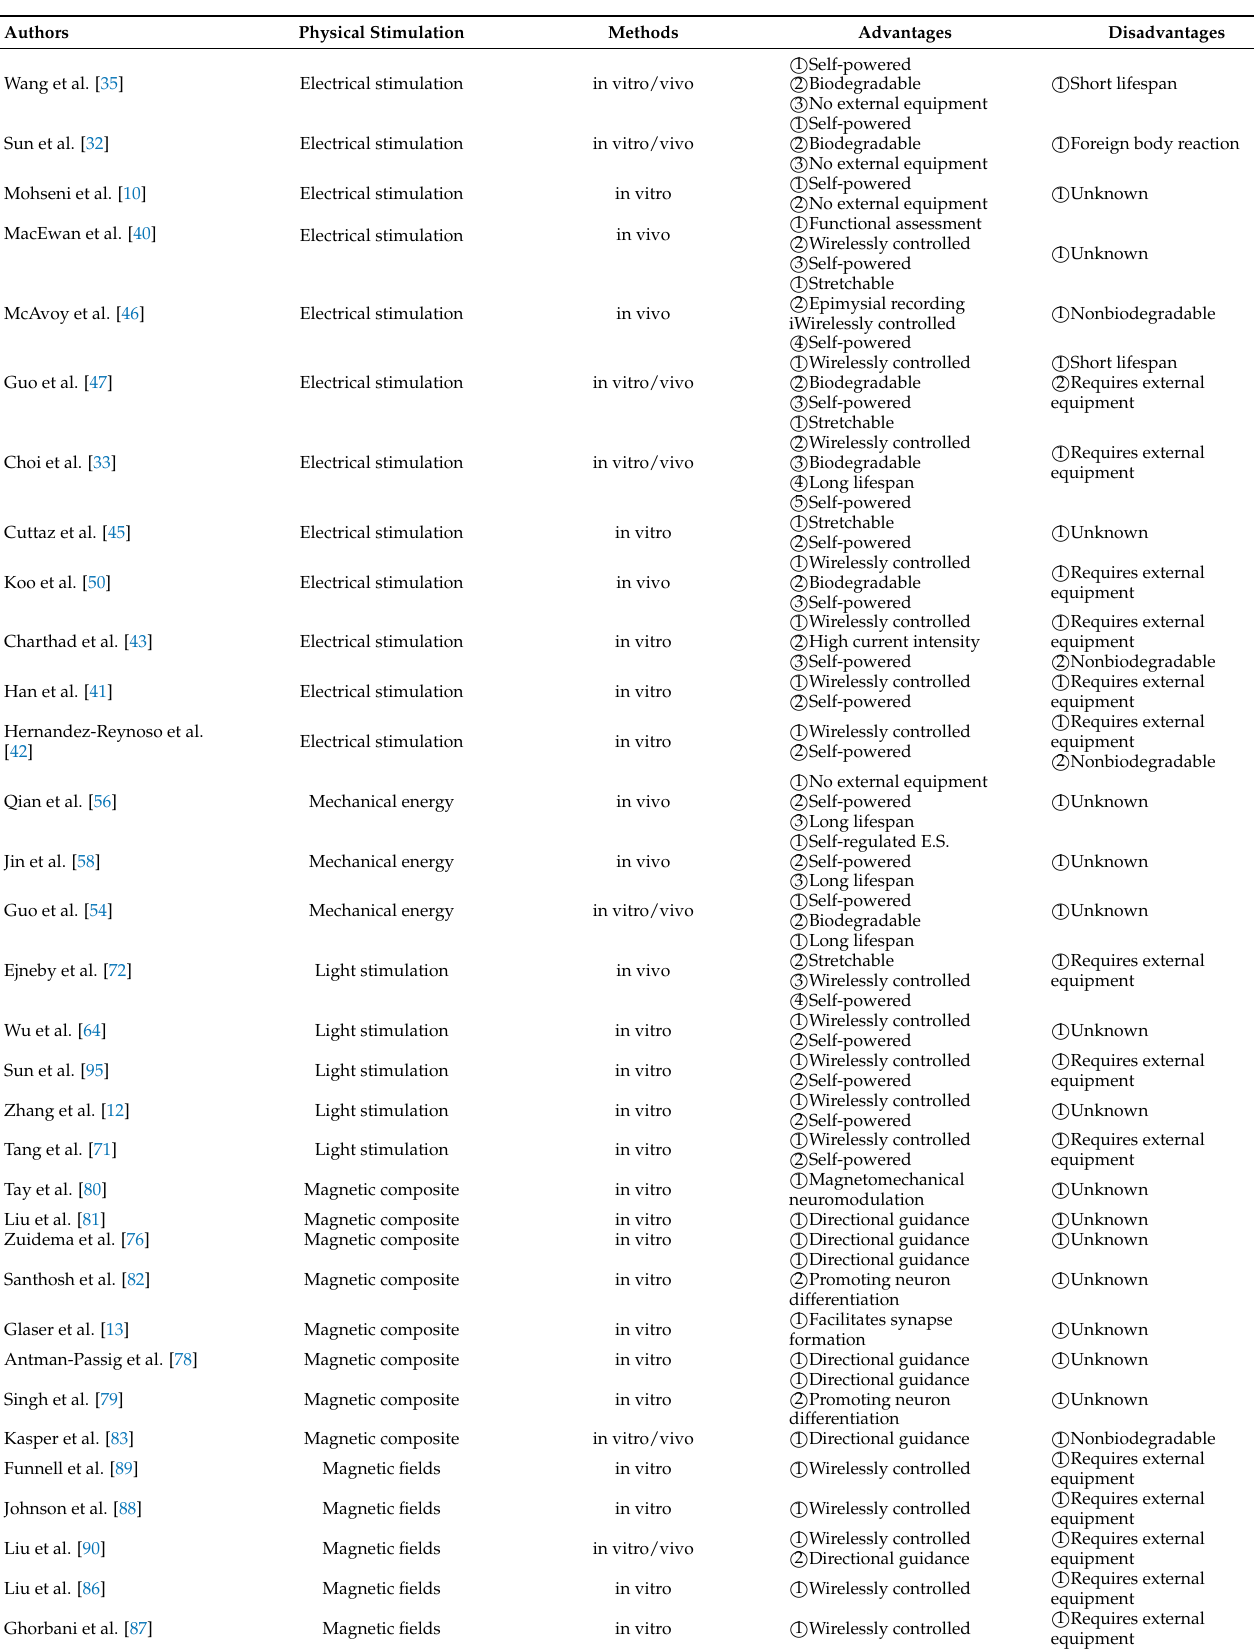
Table 1. Advantages and disadvantages of different methods of physical stimulation combined with